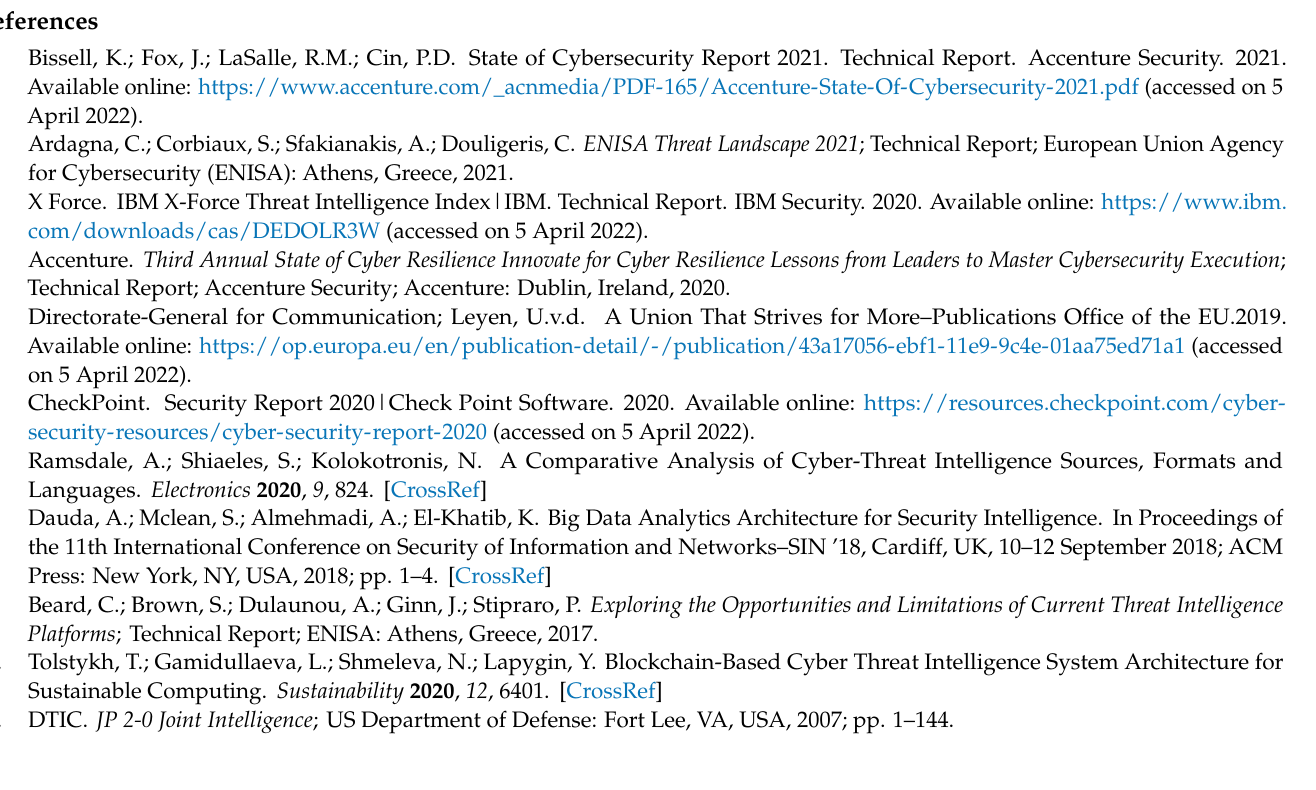
Table S2: Application of CTI Reference Model on Case Study 2, and Table S3: Application of CTI Reference Model on Case Study 3, Figure S1: CTI complexity factors concerning CTI frame of